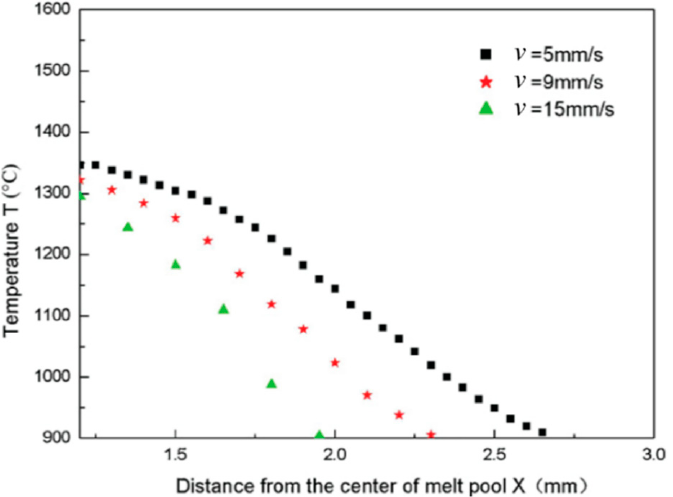
Figure 21. Effect of travel speed on temperature distribution along melt pool (reproduced with permission from [97]; Copyright © 2008 Elsevier).